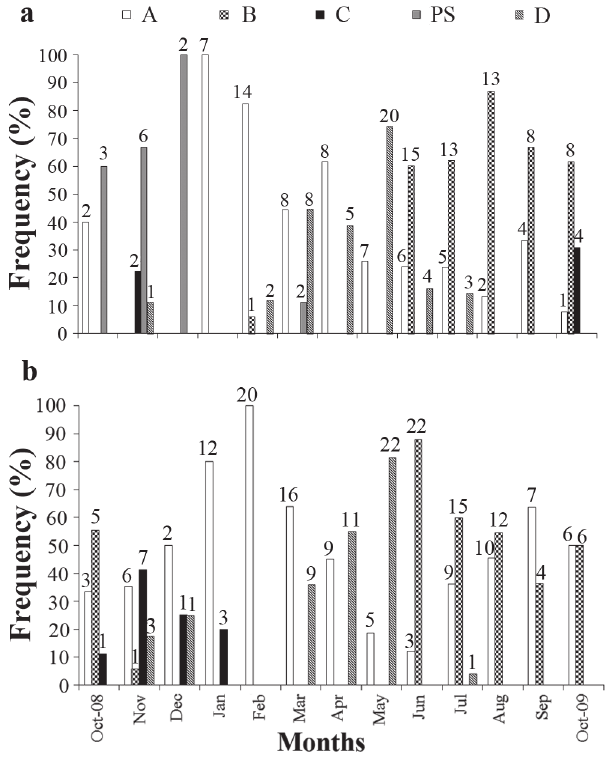
Fig. 6. Monthly percentage frequency distribution of the gonadal maturation stages of females ( a ) and males ( b ) of Etropus crossotus in the shallow infralittoral areas of the Paranaguá Estuarine Complex. A = immature; B = maturation; C = mature; PS = partially spawned; D = spawned/emptied. The numbers indicated above the bars refer to absolute